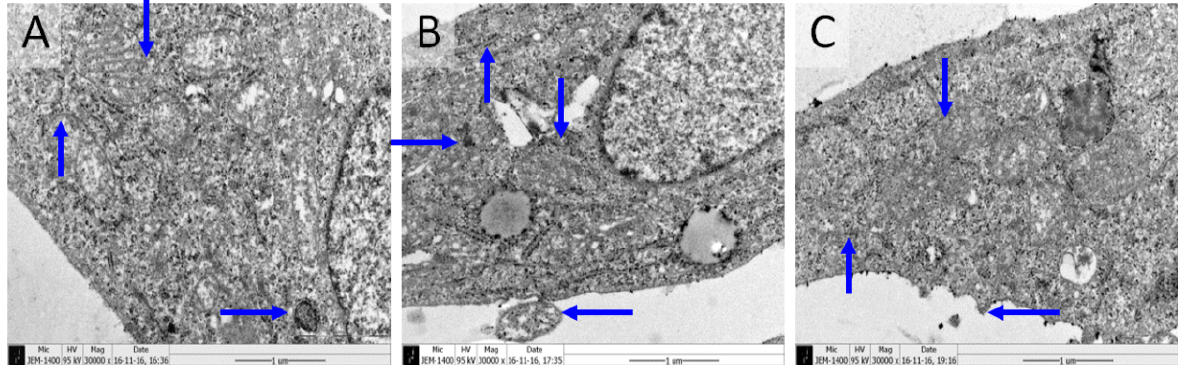
Figure 3: Representative transmission electron microscopic pictures of the ultrastructure of cells (Lead and uranium double staining, ×30000). A: control group; B: 5ng/mL TGF-β1 induced group; C: 15% GLXB-D drug serum group. Lamellar bodies ( → ), Microvilli ( ← ), Mitochondria ( ↓ ), Rough endoplasmic reticulum ( ↑